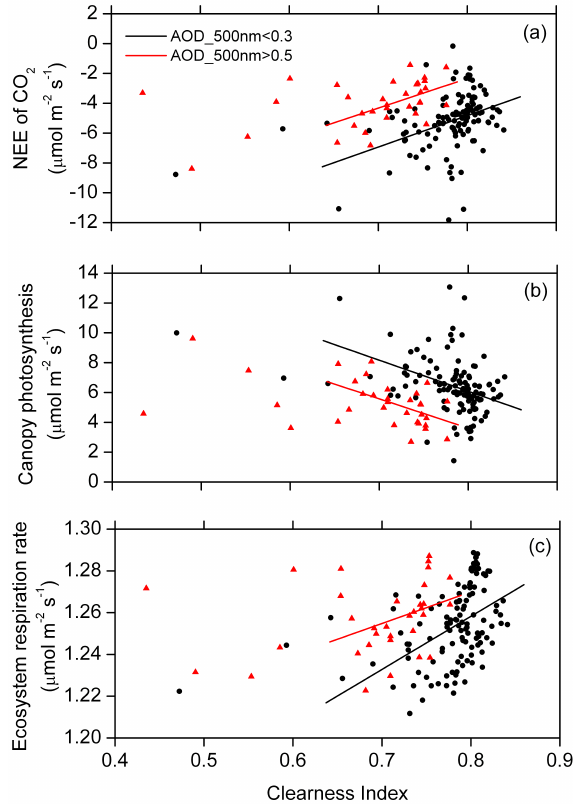
Fig. 12. Relationships between NEE of CO 2 (a) , canopy photo- synthesis (b) , ecosystem respiration rate (c) , and air temperature for linear fits. Black line: AOD < 0.3 ( n = 118, (a) r 2 = 0 . 33, (b) r 2 = 0 . 32, (c) r 2 = 0 . 99, p < 0 . 01); red line: AOD > 0.5 ( n = 33, (a) r 2 = 0 . 40 , (b) r 2 = 0 . 39, (c) r 2 = 0 . 99, p < 0 .